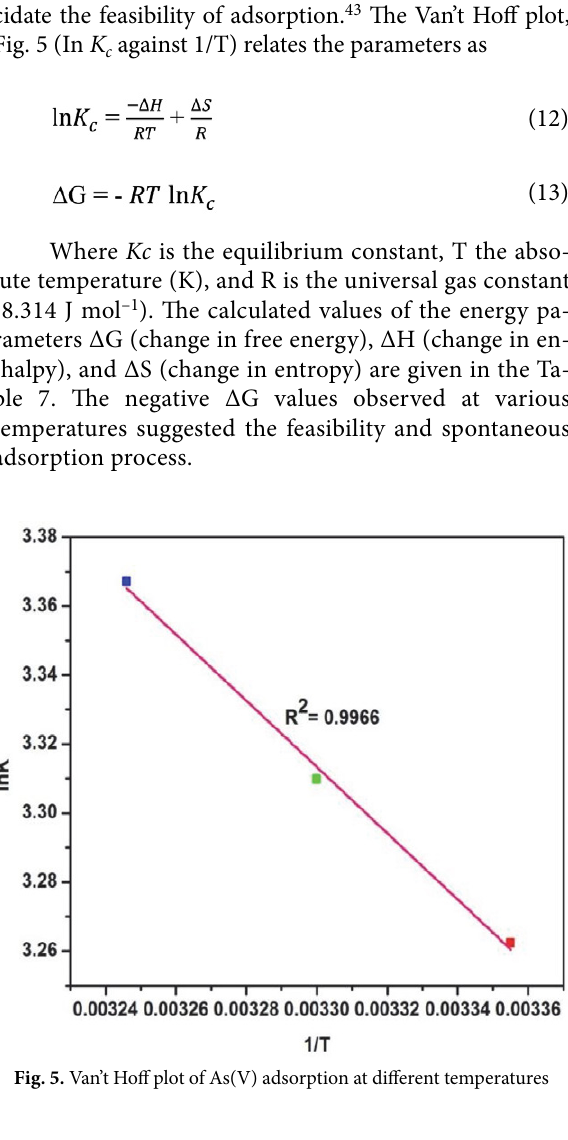
Table 6. Kinetic parameters for As(V) adsorption on pH = 6.5, adsorbent dosage = 700 mg/L, contact time = 60 min at different temperatures onto the CMC-EPI/INC composite Temp (K)